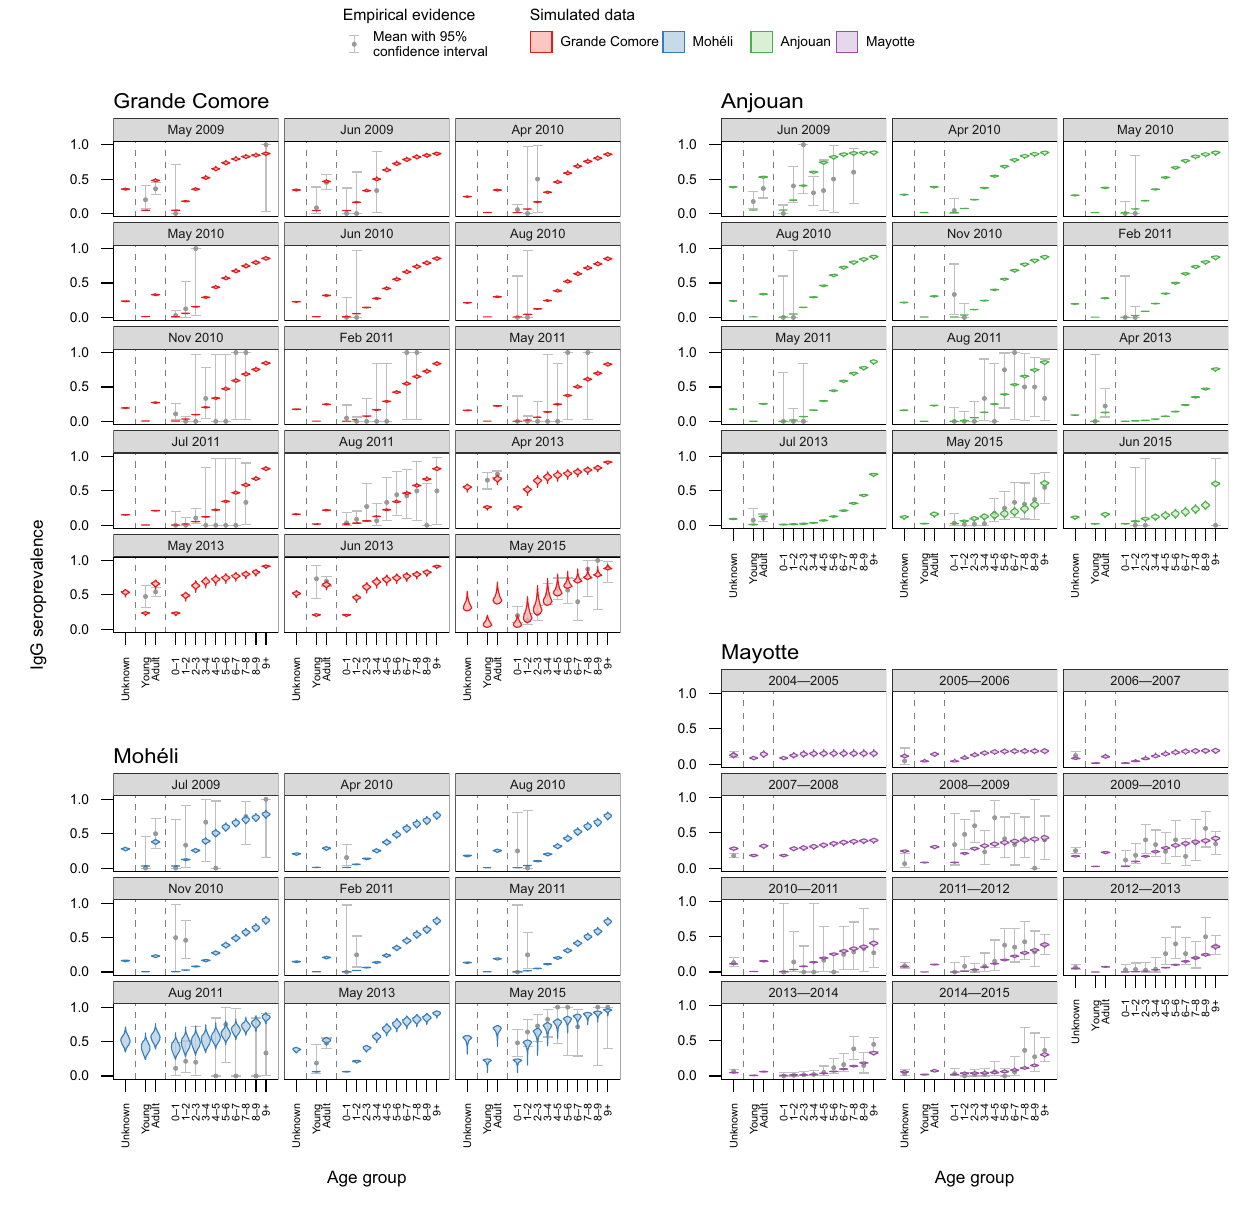
Fig. 2 Model fi t of the best fi tted model (Model 3b) to each sero-survey conducted between July 2004 and June 2015. The exponential transmission model with the same seasonal component α and different baseline transmission β for each island fi tted to the data best out of all fi ve models tested (DIC = 1189). Shown is the fi tted simulated IgG seroprevalence (coloured violins) for each aggregated sero-survey conducted throughout the study period. Seroprevalence of Grande Comore (red), Mohéli (blue) and Anjouan (green) were aggregated by month, and seroprevalence for Mayotte (purple) was aggregated by year. Simulated seroprevalence was generated through 1000 realisations of the metapopulation model. Also shown is the mean observed age-strati fi ed IgG seroprevalence (grey points) with 95% con fi dence interval (vertical error bars). The presented summary metrics were calculated from the n = 8423 biologically independent sera-samples which were used to infer the parameters of the metapopulation model. In particular, there were n = 2191 samples for Grande Comore, n = 475 samples for Mohéli, n = 857 samples for Anjouan and n = 4900 samples for